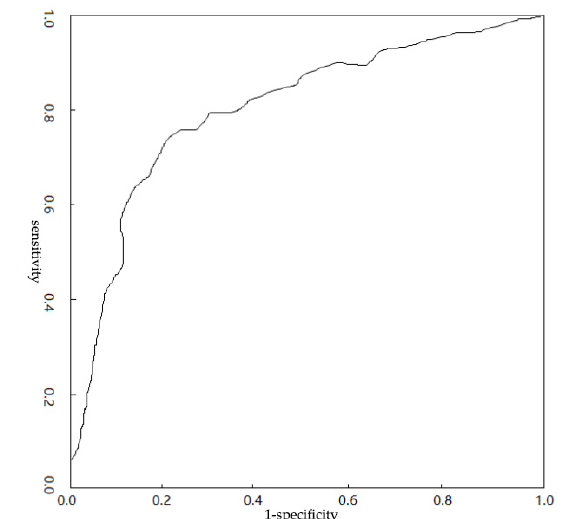
Figure 4. Cox-CSDPC disease prediction model ROC